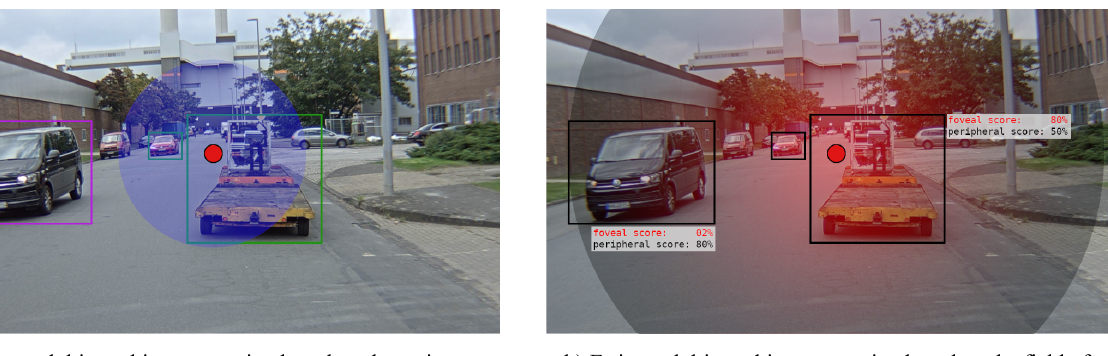
Figure 1: A typical driving situation with a fused eye tracking system and traffic object recognition. The red dot indicates the estimated fixation point in the scene. Bounding boxes indicate detected traffic objects. The left figure (a) shows a direct match- ing of fixation points to detected vehicles. Objects whose bounding box does not contain a fixation point are evaluated as not perceived. The figure on the right side (b) sketches the usage of the entire field of view to determine whether an object was per- ceived or not. Resulting in a two different scores for the perception probability of an object, one based on its proximity to the fixation point and the other one based on its visual appearance and the driver’s capability to perceive said